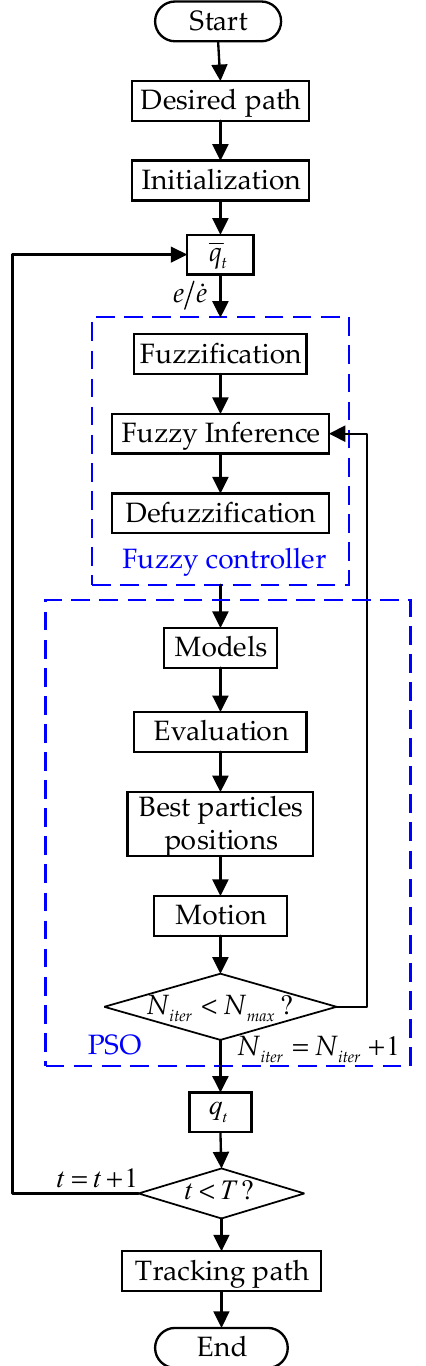
Figure 6. Flowchart for path tracking with the fuzzy controller.